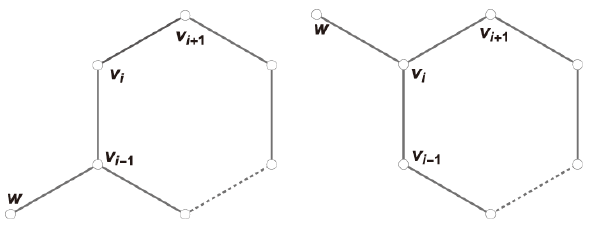
Figure 3: The case d G ( v i ) = 2 and d G ( v i +1 ) = 2 (left); the case d G ( v i ) = 3 and d G ( v i +1 ) = 2